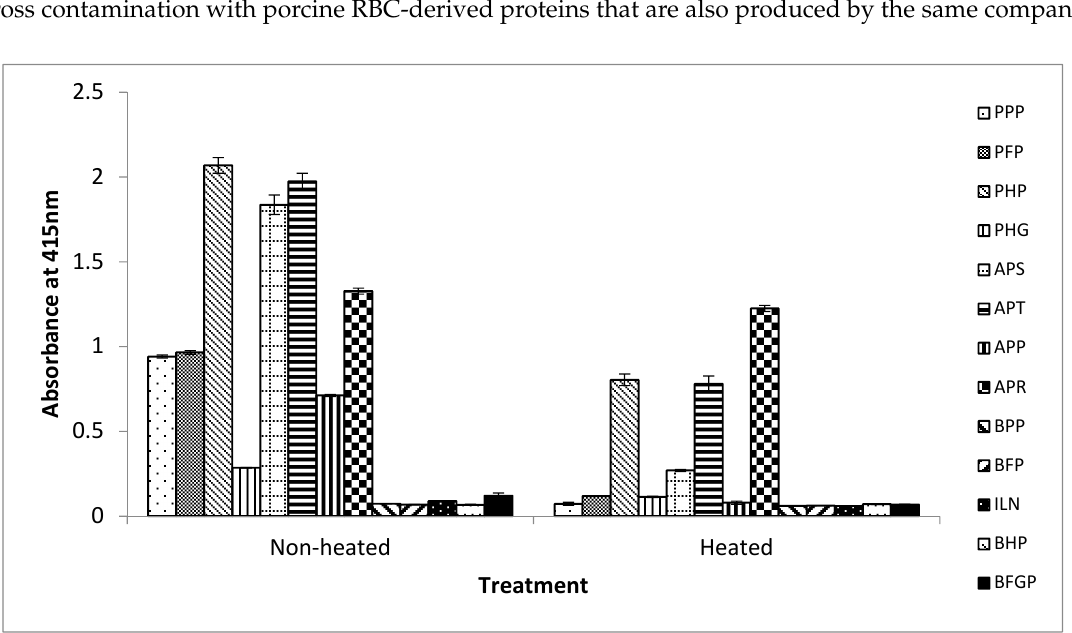
Figure 4. Reactivity of mAb 24C12-E7 with non-heated and heated bovine and porcine blood-derived food ingredients using iELISA. Soluble proteins extracted from these blood-derived proteins were coated at 0.5 μ g/100 μ L. mAb 24C12-E7 supernatant was diluted 1:50 in 0.2% fish gelatin in PBST. Results are expressed as A 415 ± SD, n = 3. PPP: porcine plasma powder; PFP: porcine Fibrimex ® powder; PHP: porcine hemoglobin powder; PHG: porcine hydrolyzed globin; APS: Aprosan; APT: Aprothem; APP: Apropork; APR: Aprored; BPP: bovine plasma powder; BFP: bovine Fibrimex ® powder; ILN: Immunolin ® ; BHP: bovine hemoglobin powder; and BFGP: bovine fibrinogen powder.